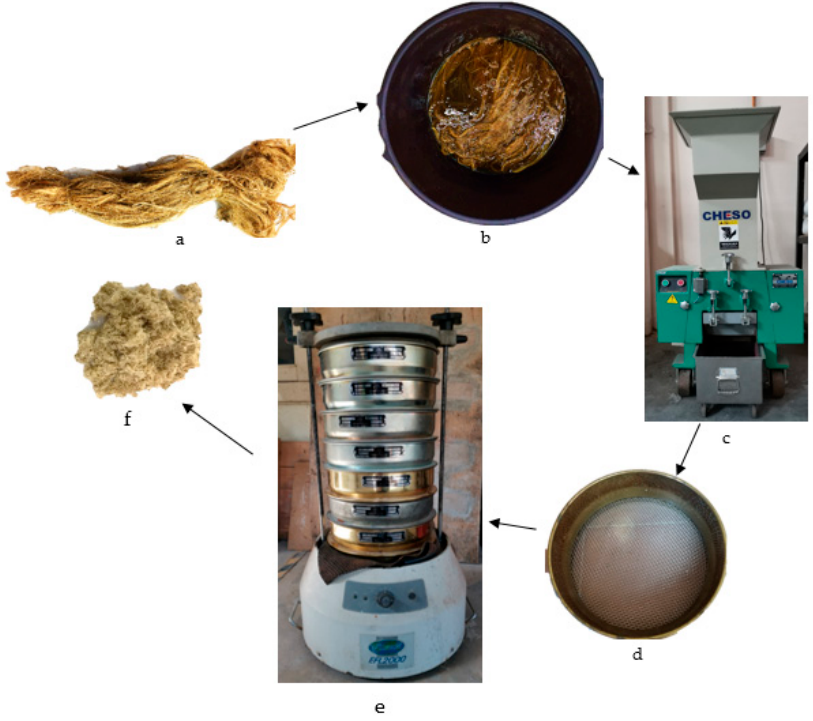
Figure 1. Photos of ( a ) long banana fibers, ( b ) chemically retted fibers, ( c ) fiber chopping machine, ( d ) 3.35-mm brass frame sieve, ( e ) rotational shaker, and ( f ) short banana fibers.